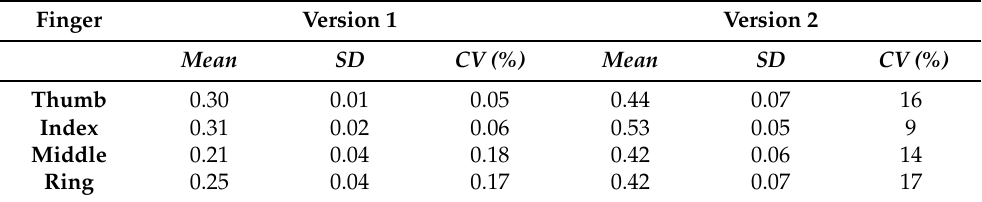
Table 2. Variability of demonstrator relative resistance change measurements for